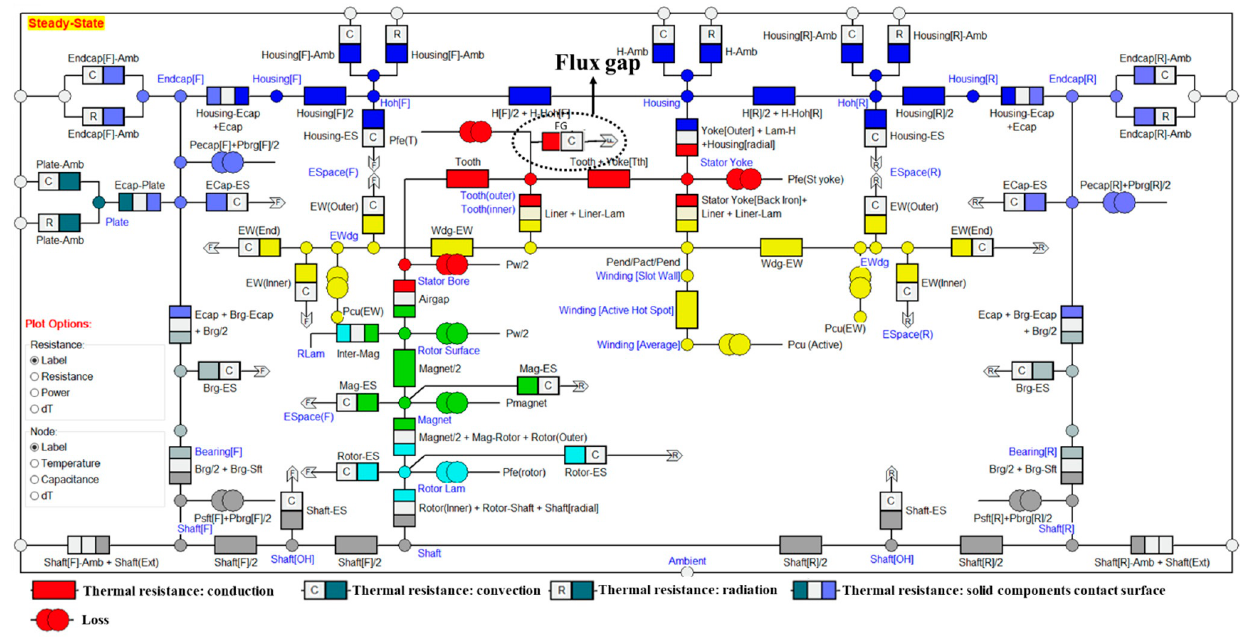
Figure A3. LPTN model based on Motor-CAD for the modular machine.